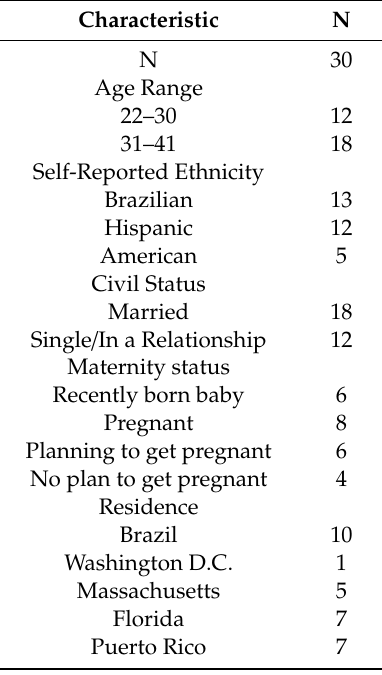
Table 1. Sociodemographic characteristics of the women